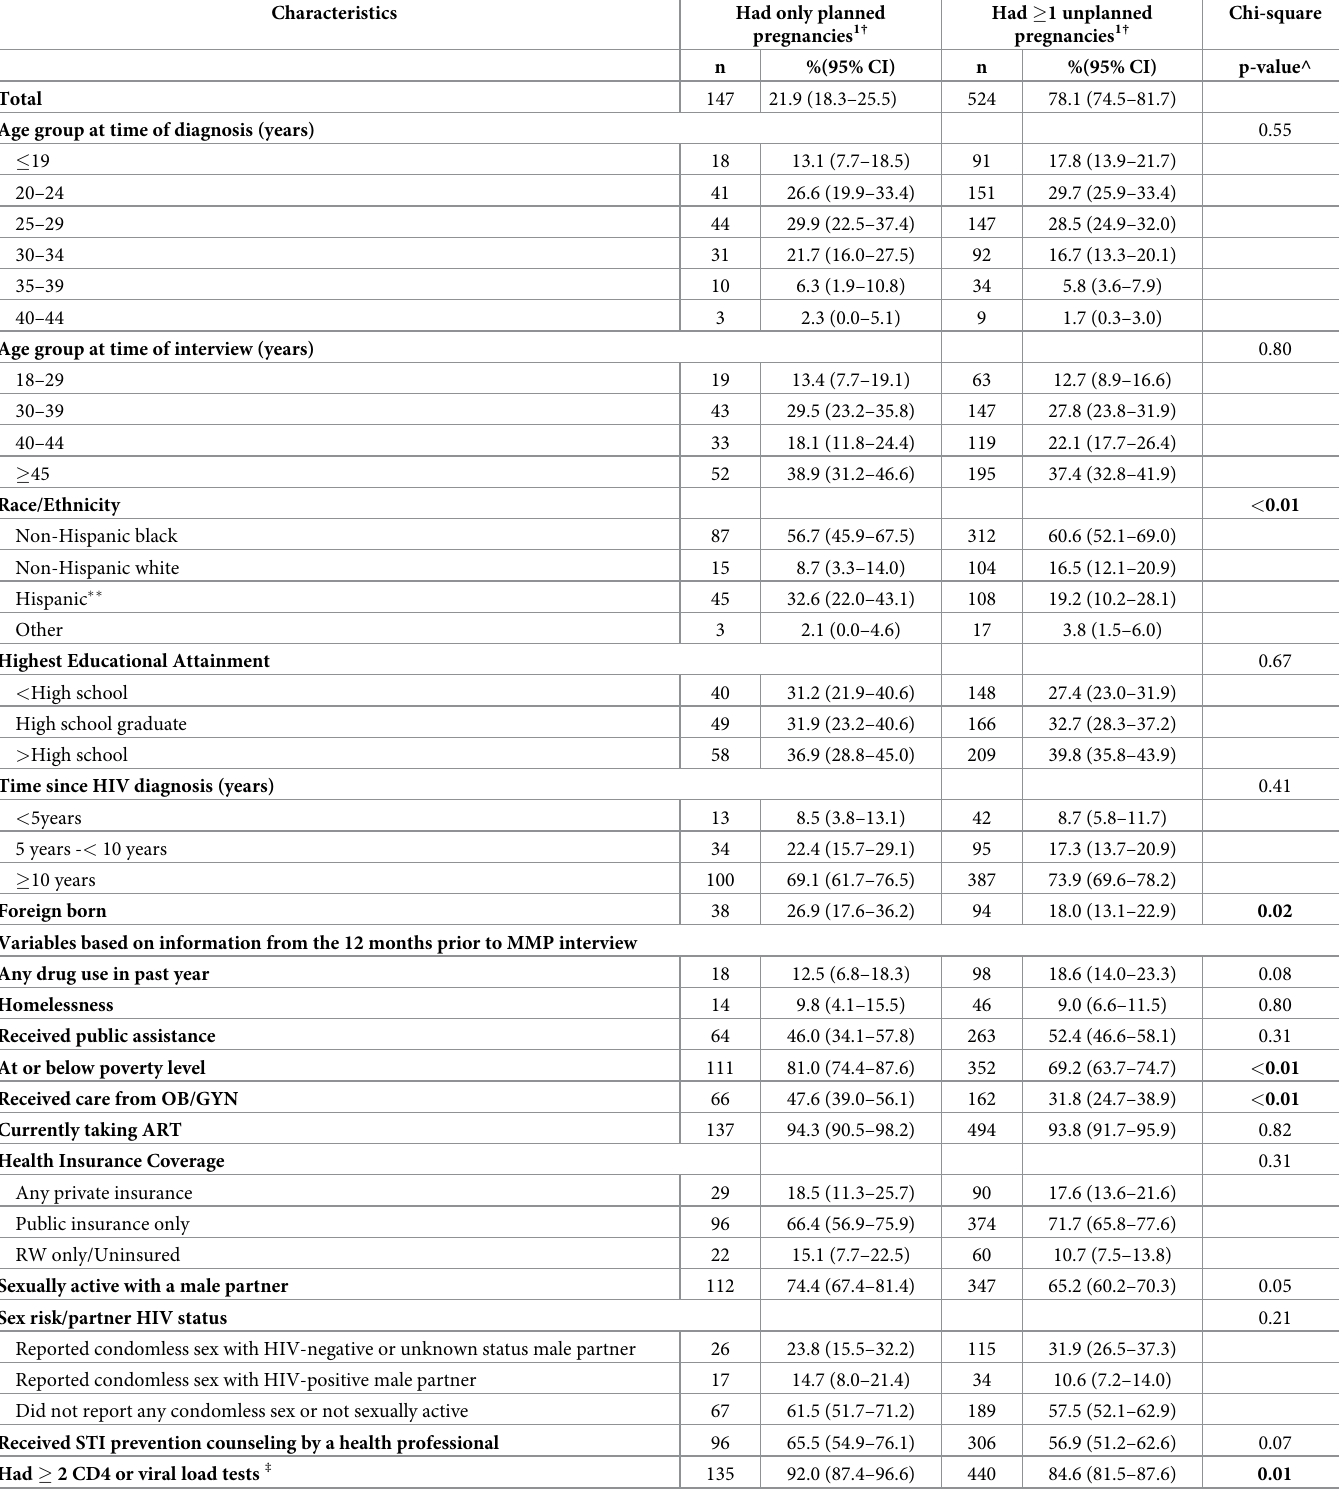
Table 1. Selected characteristics of HIV-positive women in care who had a pregnancy since HIV diagnosis, by only planned pregnancies vs. (cid:21) 1 unplanned pregnan- cies—Medical Monitoring Project—2013–2014 (N = 671).